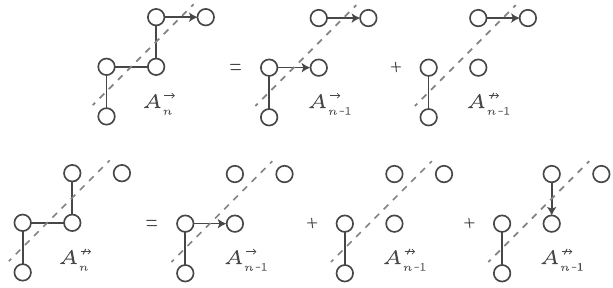
FIG. 3. A → μ and A → μ can be constructed recursively, as shown above. Here, arrows indicate information flow, while edges indicate the possibility of information